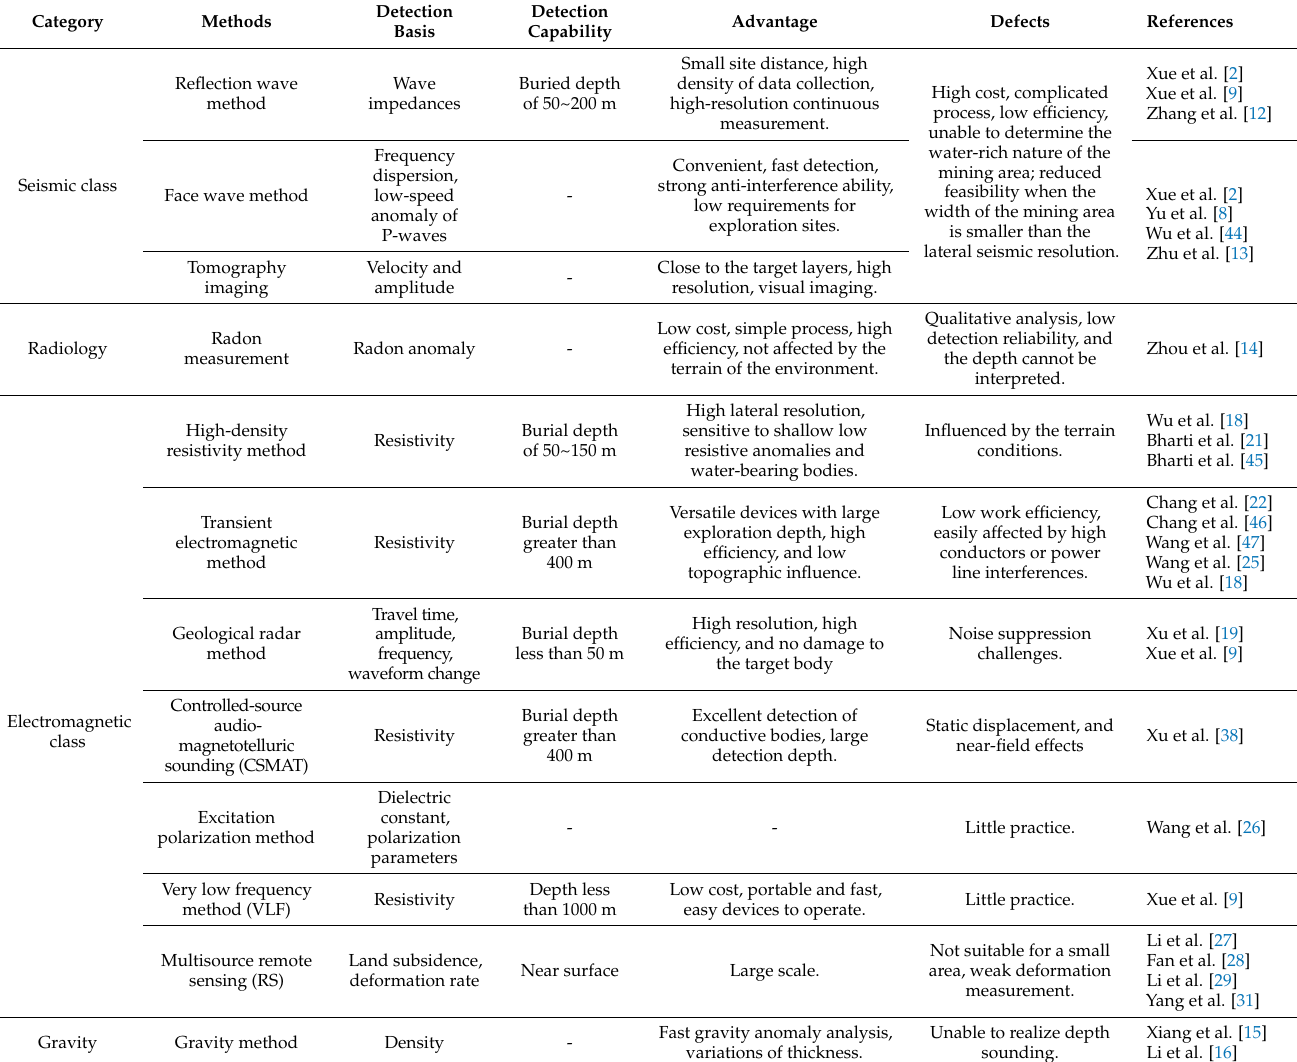
Table 1. A summary of classical geophysical methods in coal mine goaf